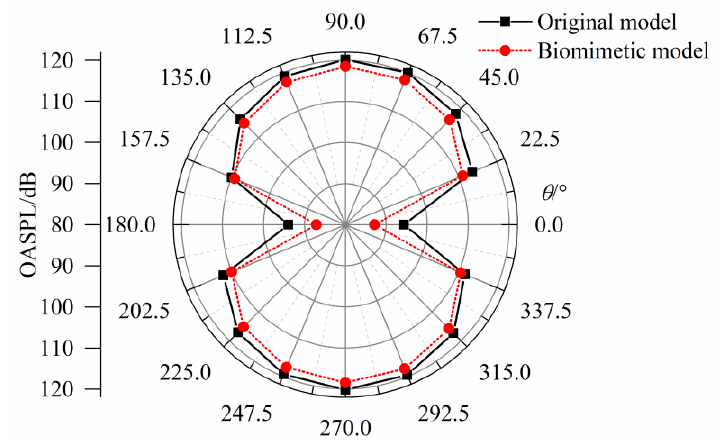
Figure 21. Comparison of predicted OASPLs of the original hydrofoil and biomimetic hydrofoil at the 16 observing points of the far sound field.